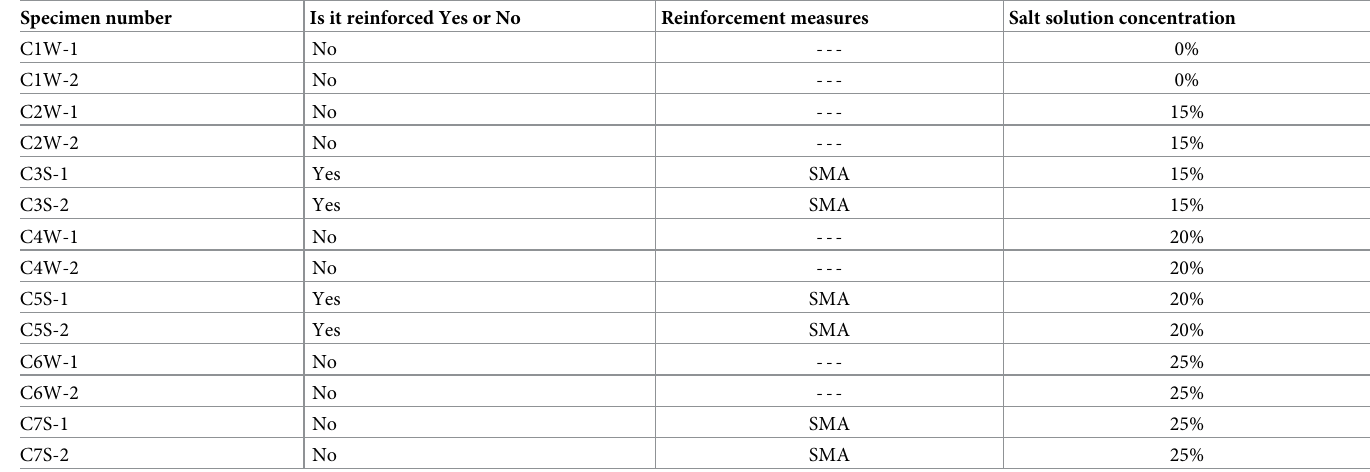
Table 1. Specimens design.